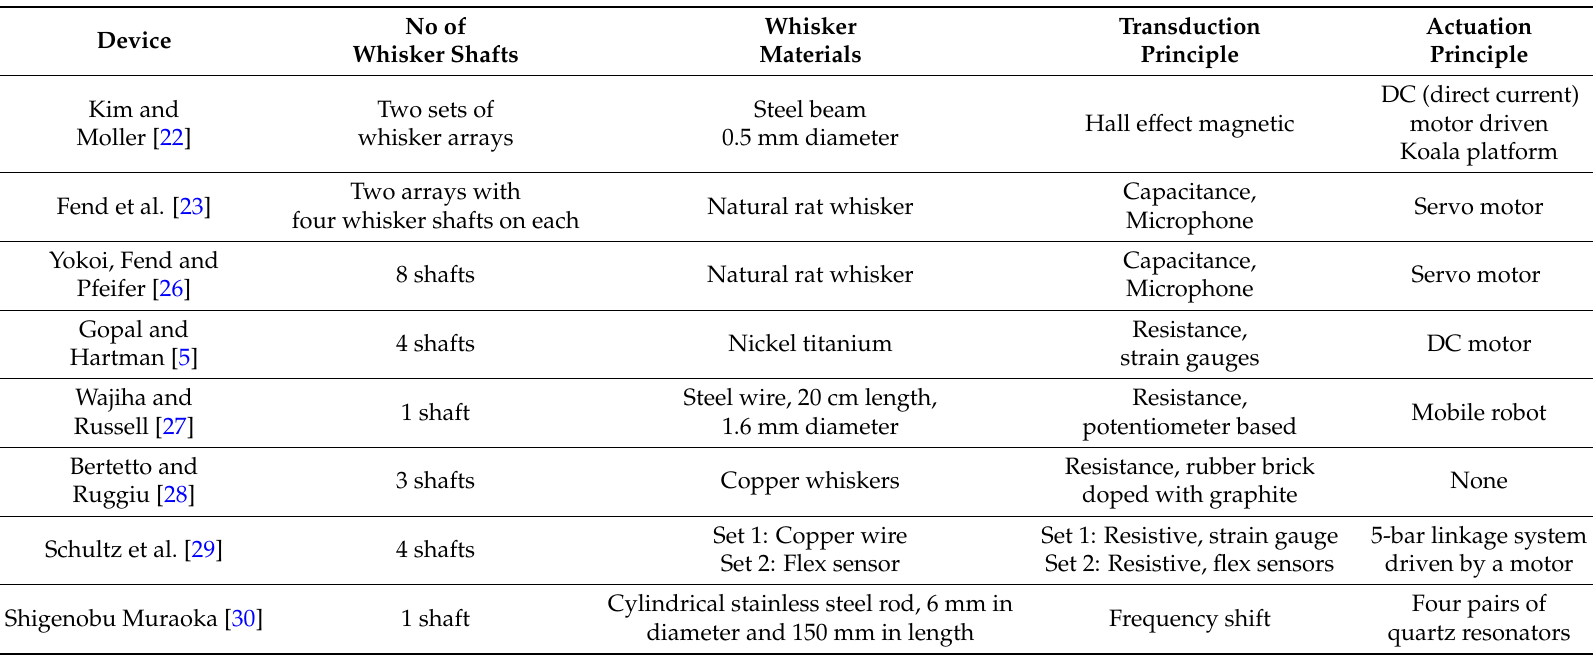
Table 1. A summary of the previously reported whisker-inspired designs. It can be noted that none of these devices employed Polyvinylidene fluoride (PVDF) as a sensing element and lacked the ability to induce micro-motions in the sensory whiskers. These devices also did not mimic the frequency response of natural whiskers. Both of these limitations have been addressed in this